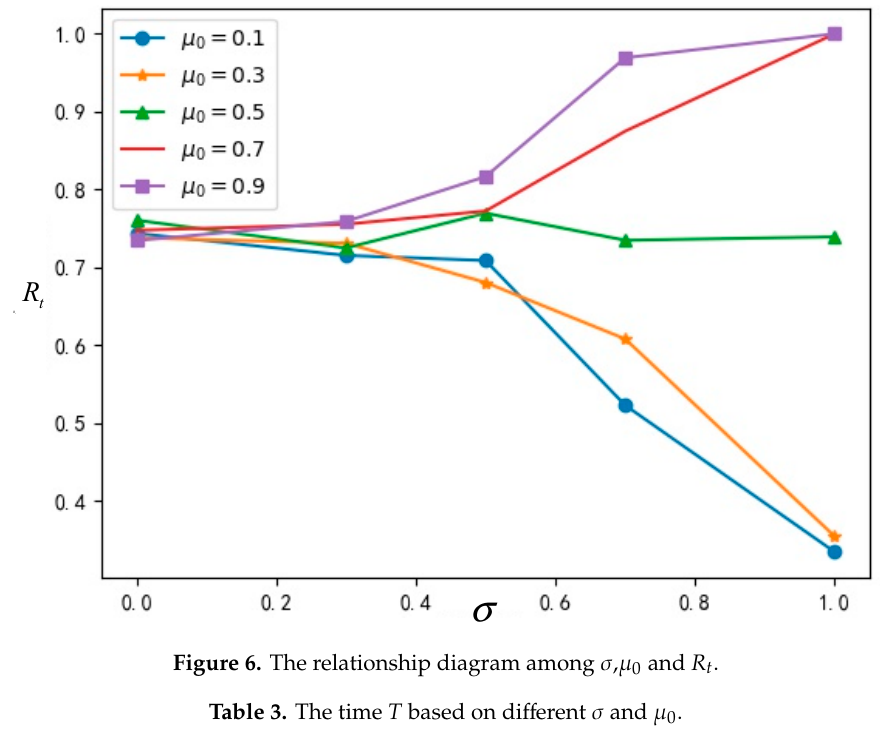
μ σ , 0 and . Figure 6. The relationship diagram among σ , µ 0 and R t .